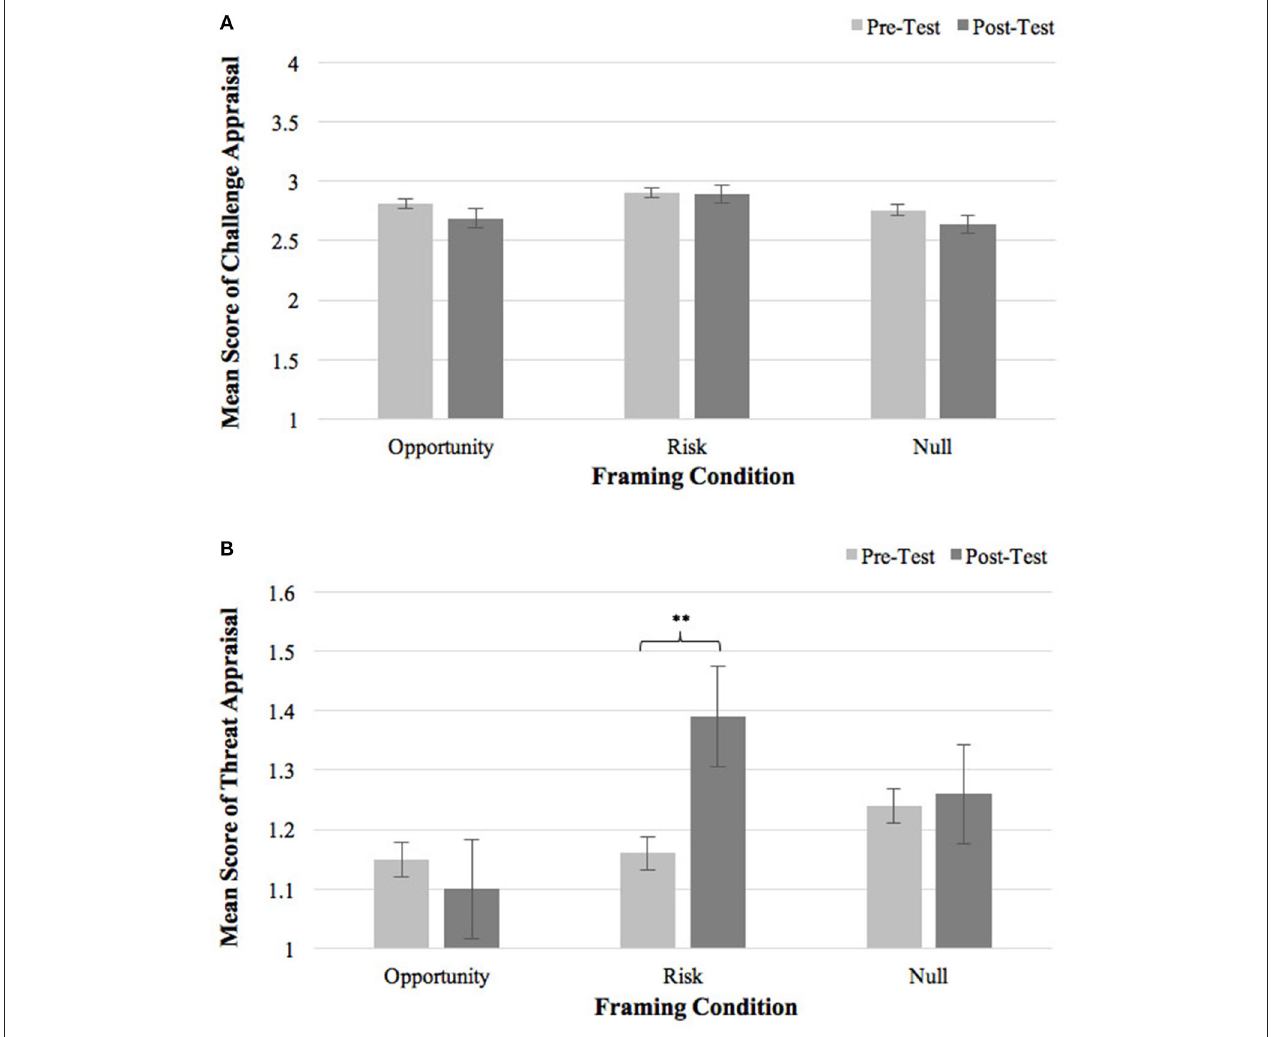
FIGURE 3 | (A) Pre- and post-framing challenge appraisal in three framing conditions. (B) Pre- and post-framing threat appraisal in three framing conditions. Error bars represent standard errors. ** p <